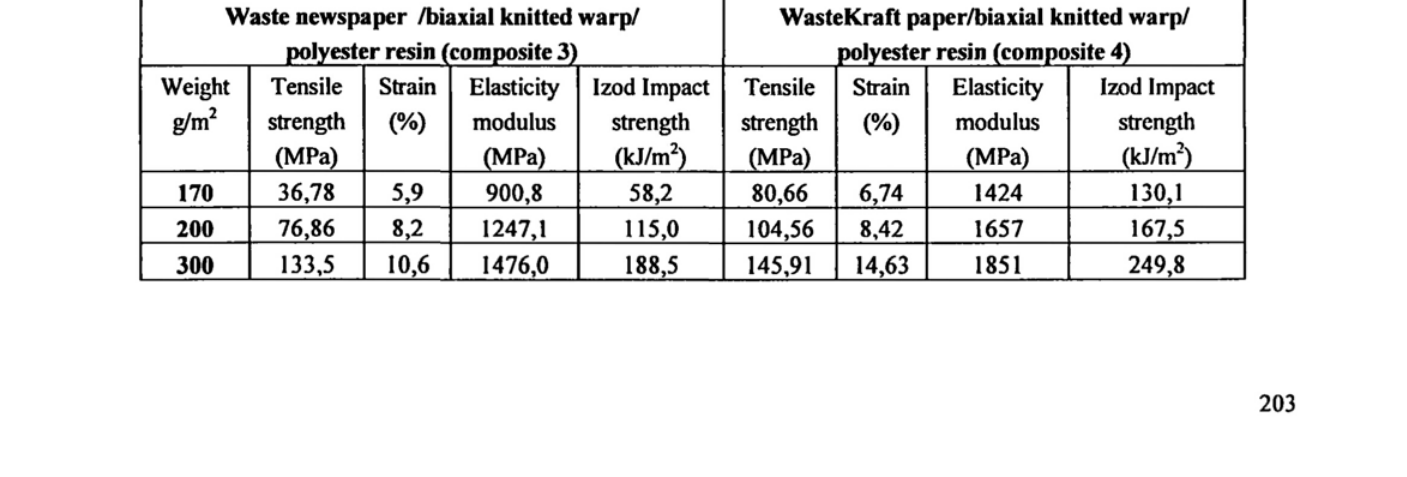
Waste newspaper/biaxial knitted warp/polyester resin and waste Kraft paper /biaxial knitted warp/polyester resin properties Waste newspaper /biaxial knitted